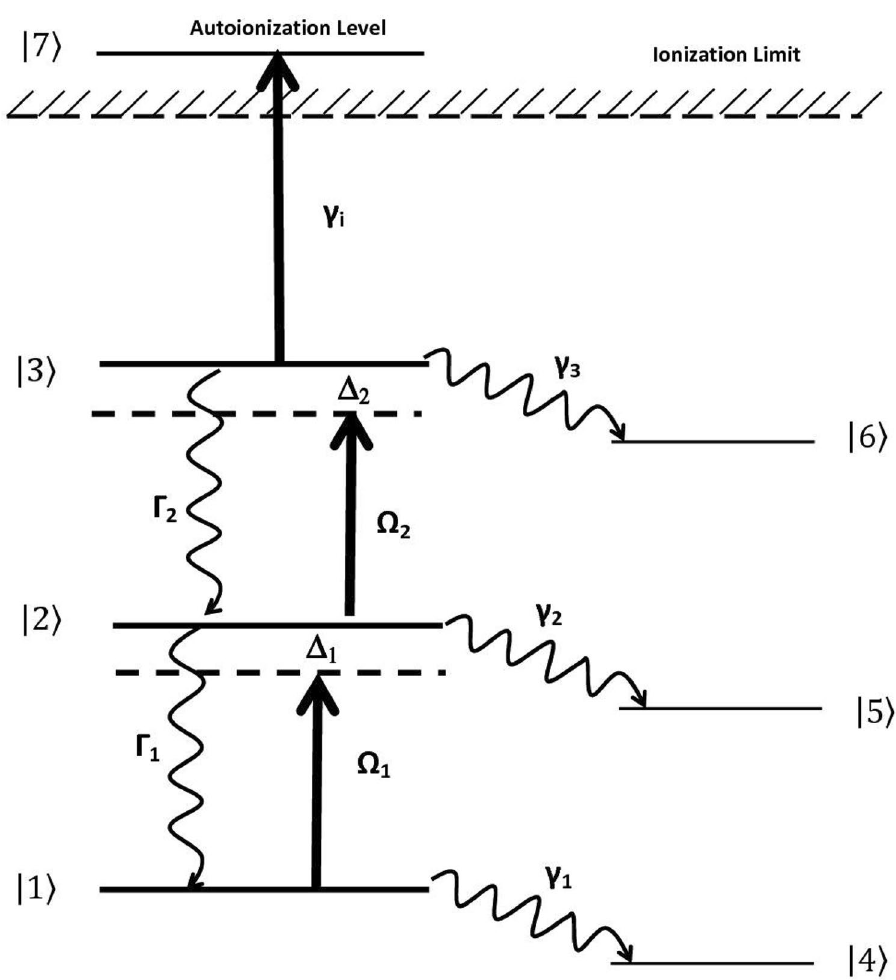
Figure 1. Schematic representation of the resonant three step photionization of Neodymium (not to